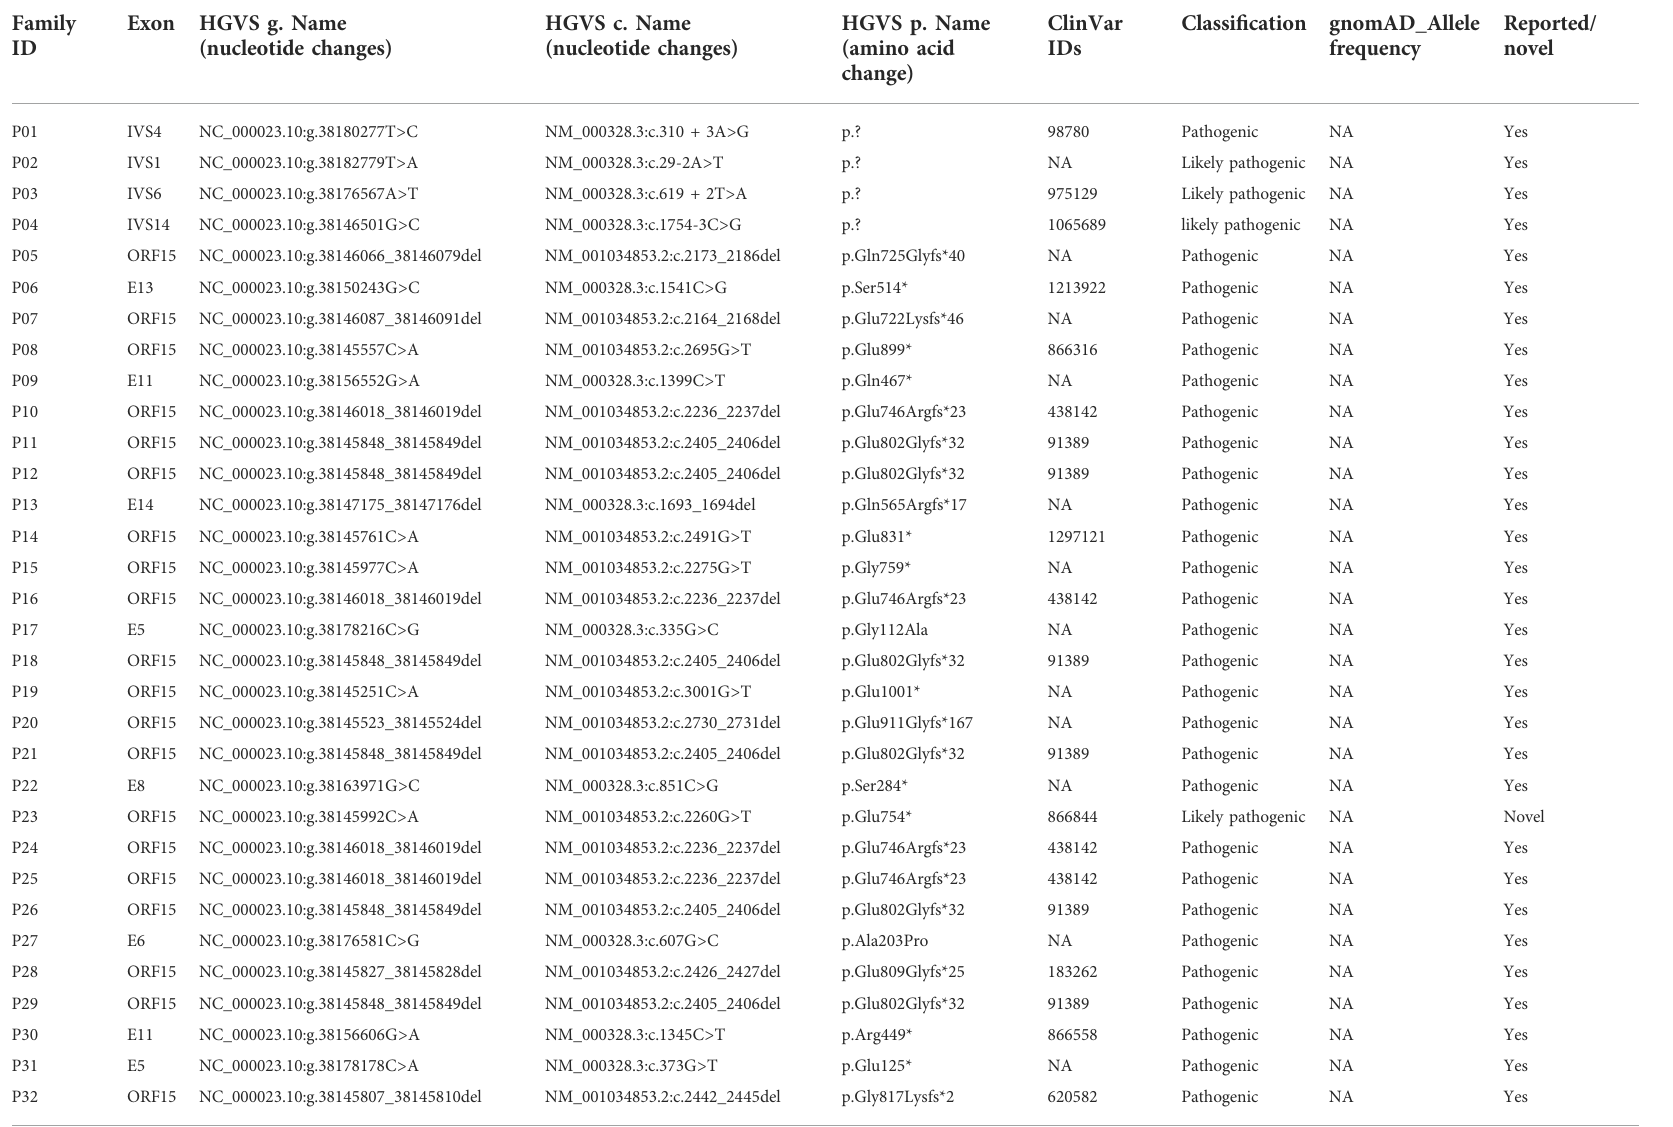
TABLE 2 Genetic Diagnosis of 41 Chinese XLRP families caused by RPGR